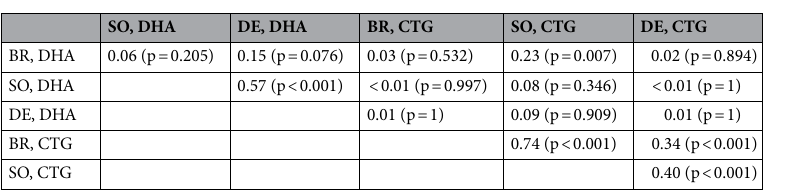
Table 1. Pairwise comparison of catchment areas according to the city supplied and the type of chickens traded using Pianka’s overlap indices 19 . An index of 0 meant that both catchment areas did not overlap at all, and an index of 1 that they were identical. BR broiler, SO sonali, DE deshi, DHA Dhaka, CTG Chattogram; in brackets: p-value.